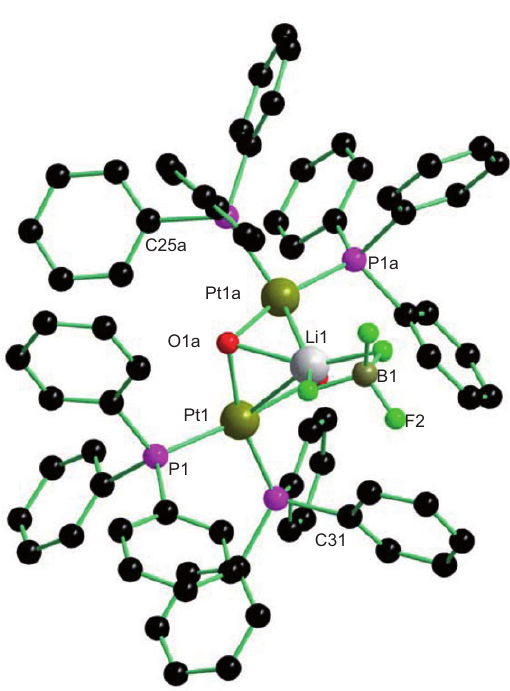
)Pt( μ -Cl)( μ -SOP)(OPr i ) 3